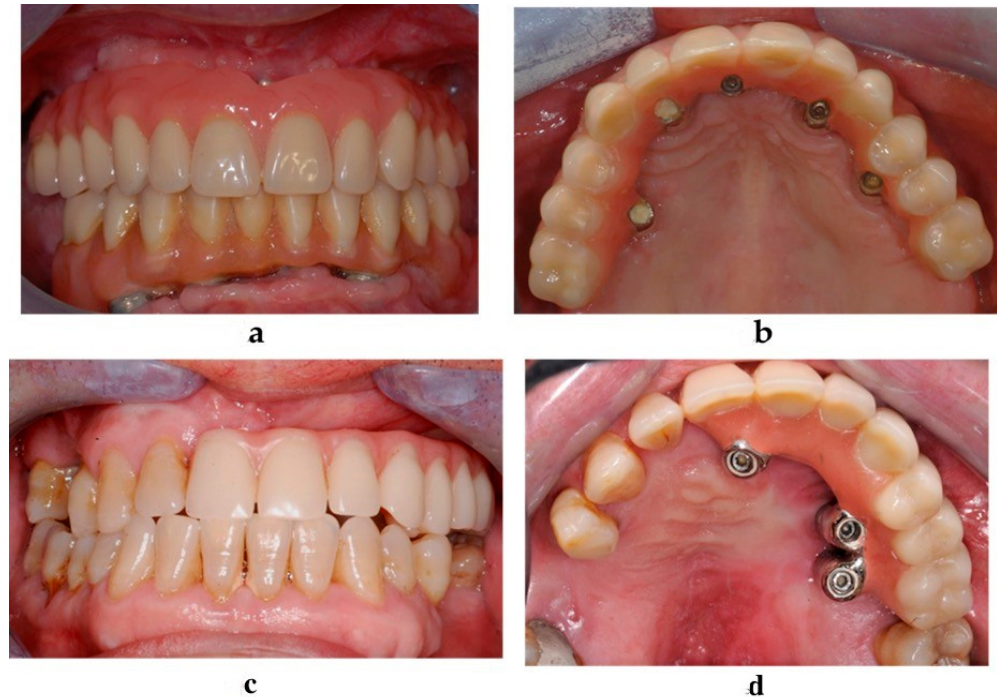
Figure 4. Clinical evaluation and soft tissue maintenance in the atrophic group ( a , b ) and in the oncologic group ( c , d ): frontal view ( a ), palatal view ( b